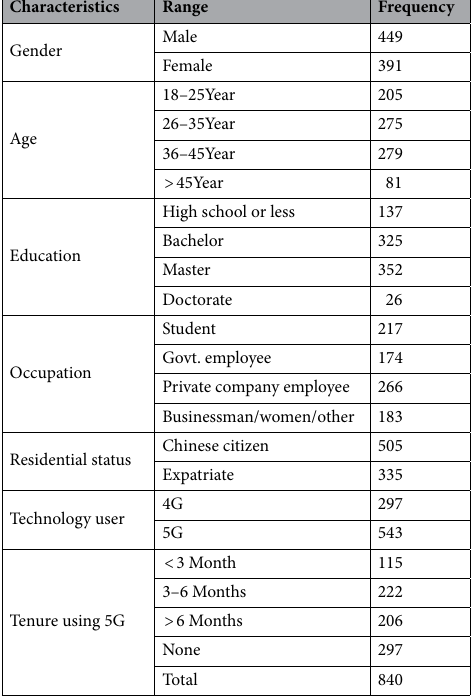
Table 1. Demographic